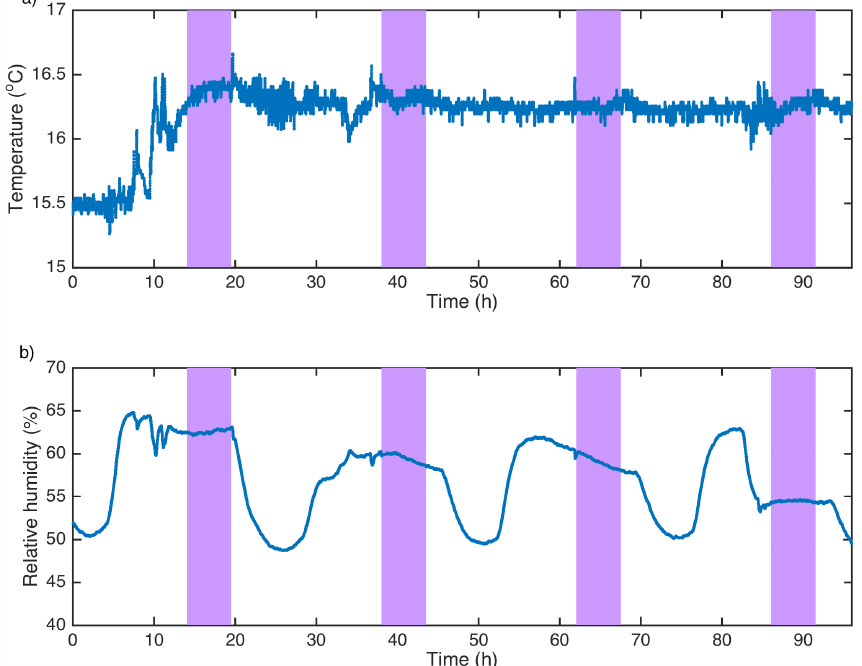
Figure 2. Measured temperature (a) and relative humidity (b) in the JPAC reaction chamber during the first 4days of the measurement campaign. The purple bars indicate UV on